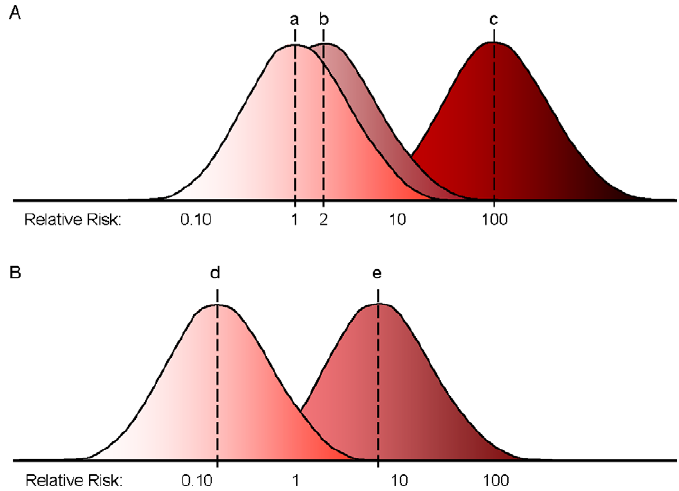
Fig. 2. Relative distribution of populations at risk for familial and sporadic cancer. A: The relative risk for the general population (‘population a’) to get cancer is 1. Determination of genetic predisposition to cancer by genotyping of intermediate- and high-penetrance TSGs will reveal (small) subpopulations of people at intermediate (‘population b’) and high (‘population c’) risk for cancer. B: The general population harbors relatively large subpopulations of people at low risk (‘population d’) and high risk (‘population e’) for sporadic cancer. New methods are being developed to identify these populations, by characterization of cancer-associated biological modules that reveal the net effect of networks of low-penetrance